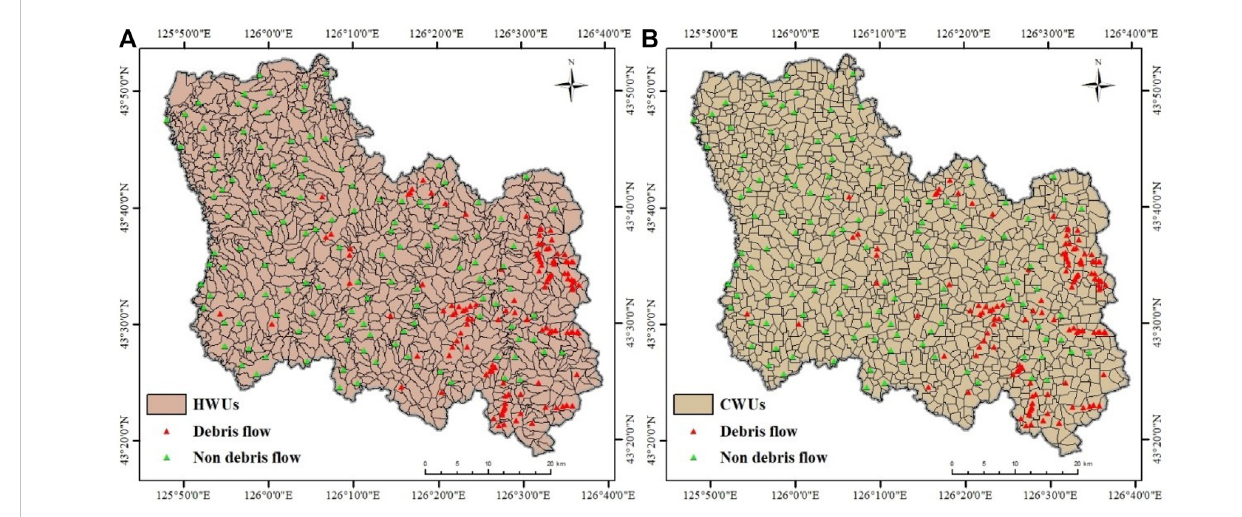
FIGURE 4 Division of watershed units: (A) hydrological analysis method and (B) mean curvature